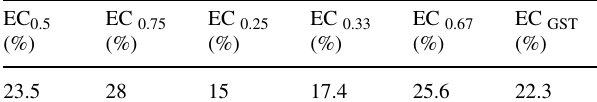
Table 12 EC quantiles for Gastwirth median